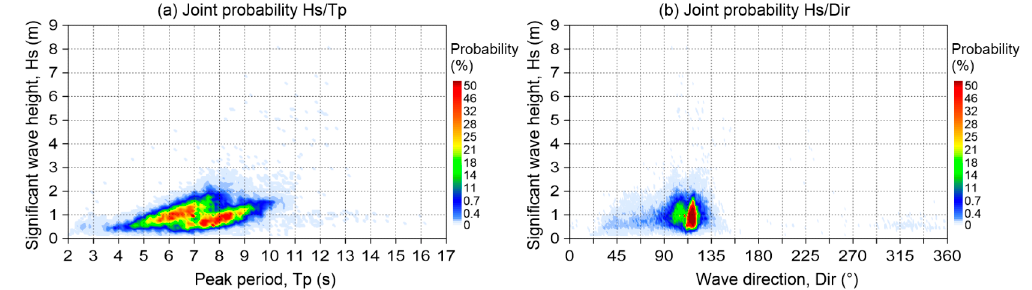
Figure 9. Seasonal wave roses: ( a ) Spring; ( b ) Summer; ( c ) Autumn; ( d ) Winter.